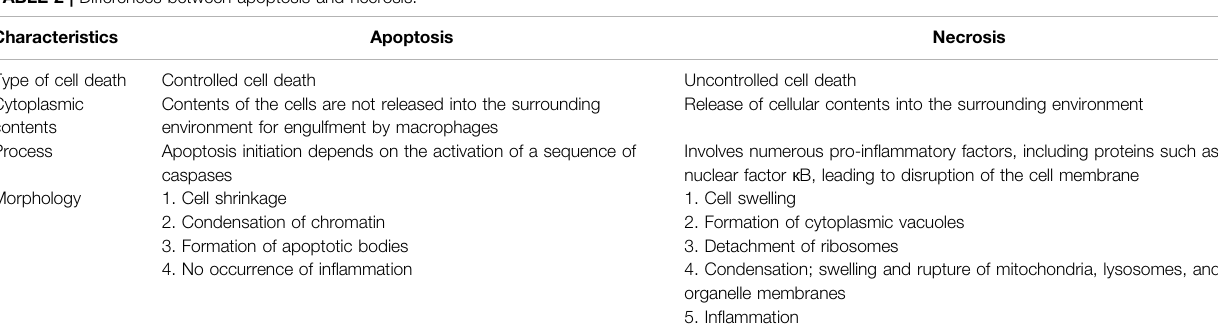
TABLE 2 | Differences between apoptosis and